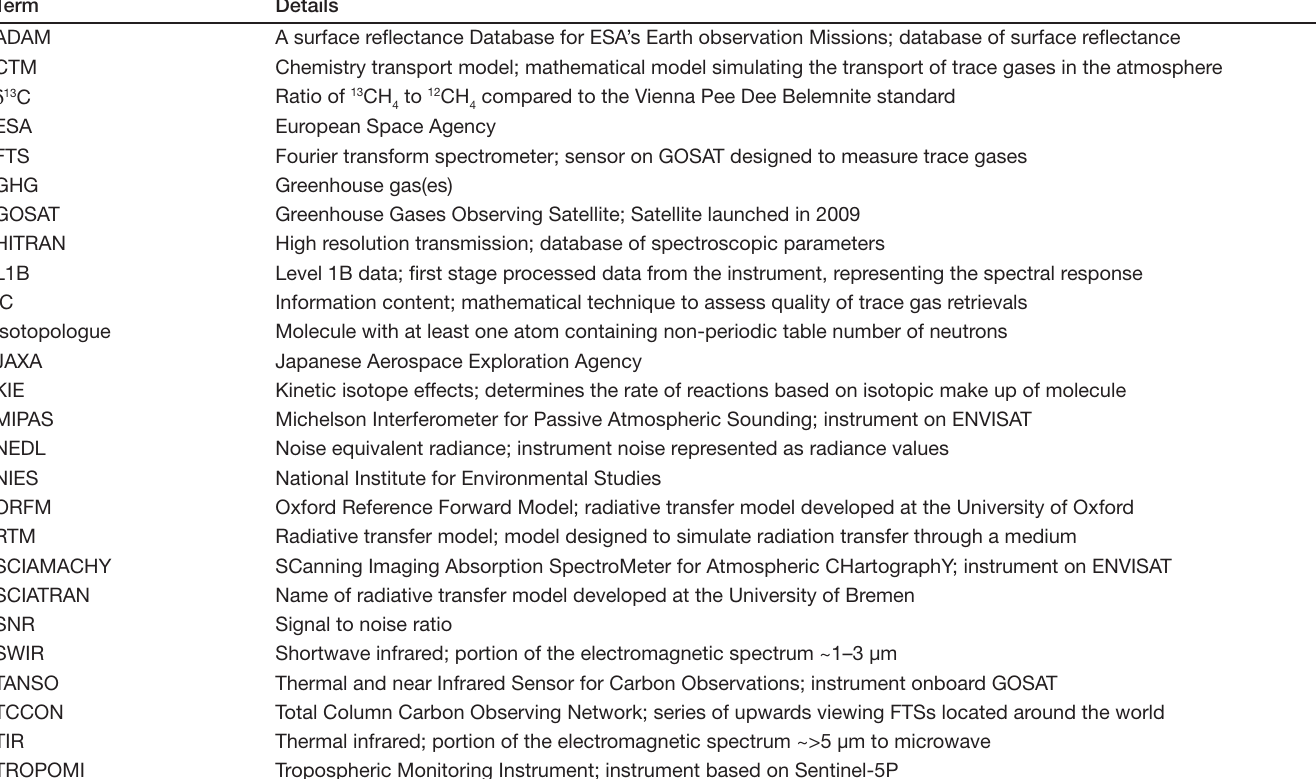
Table 6 provides a table of key terms and acronyms. Table 6. Glossary of key terms and acronyms used in this